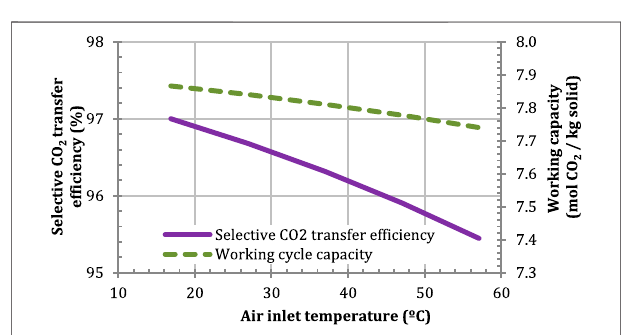
FIGURE 13 | Effect of the air inlet temperature on the selective CO 2 transfer for a given solid mass of 326.21 t. Con fi guration: parallel S-EGR at 70% recirculation ratio.